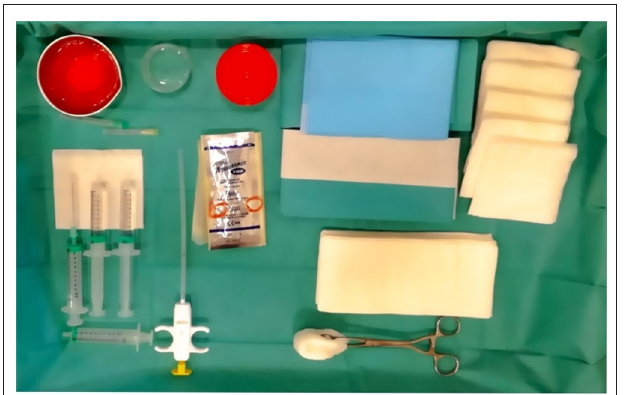
FIGURE 3 | Materials required for USGSB.